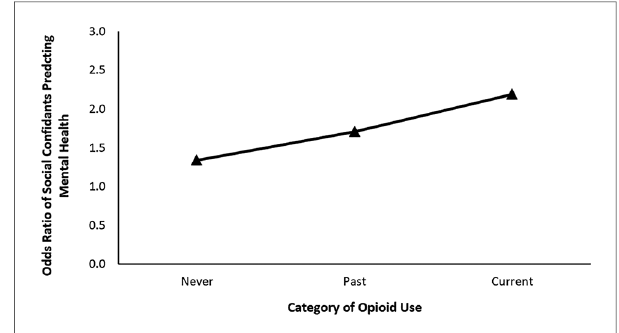
FIGURE 2 Odds ratio of social con fi dants predicting self-reported mental health at each level of opioid use for females reporting high shame surrounding substance